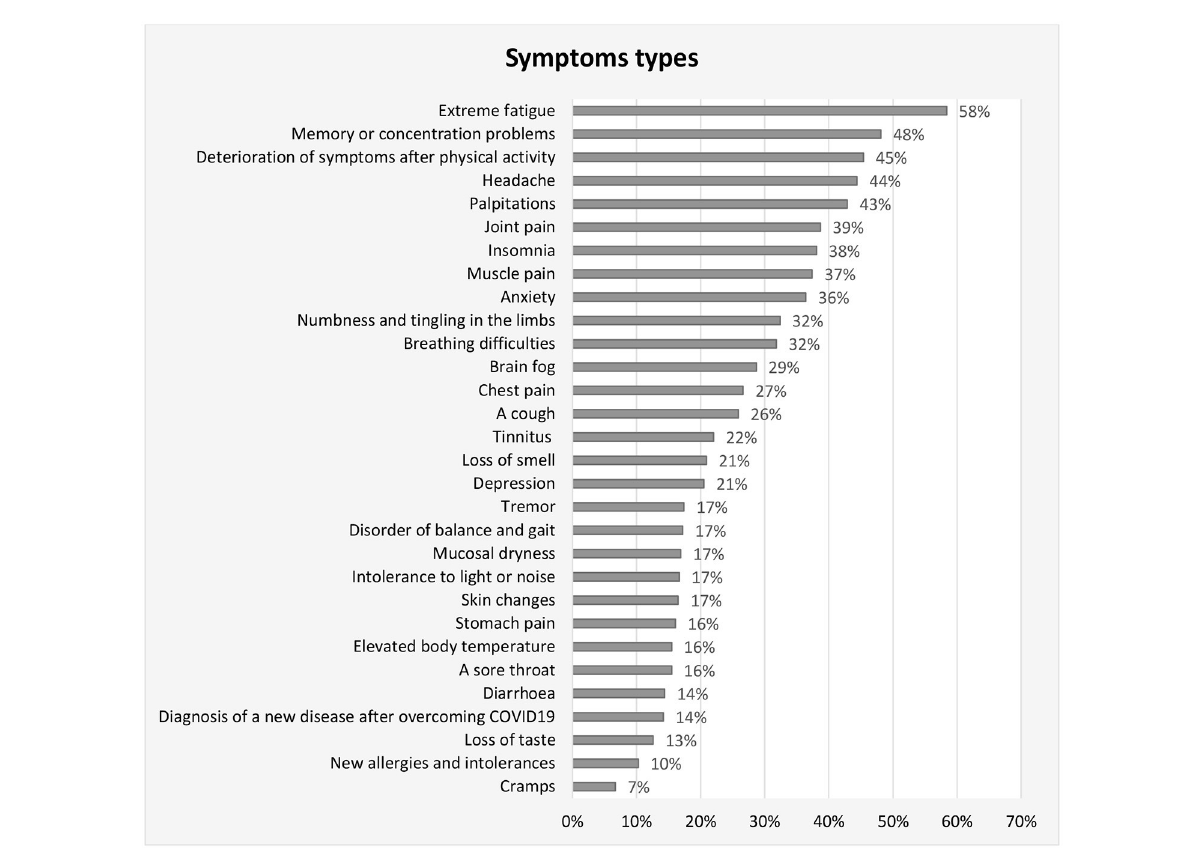
FIGURE1 Types of symptoms among patients with long COVID.